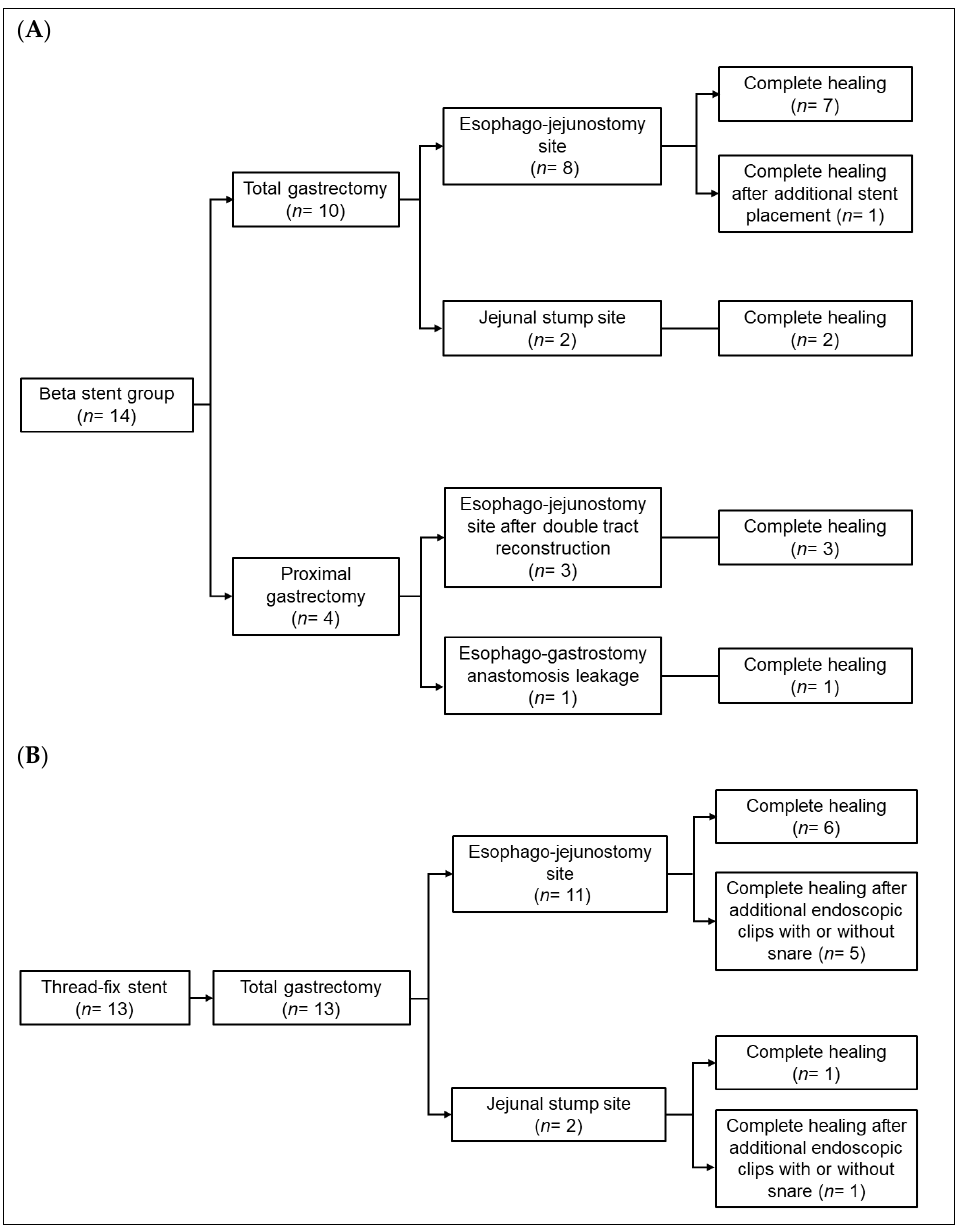
Figure 3. Detailed treatment outcomes after stent placement. ( A ) Beta Stent Group. ( B ) Thread-Fix Group.